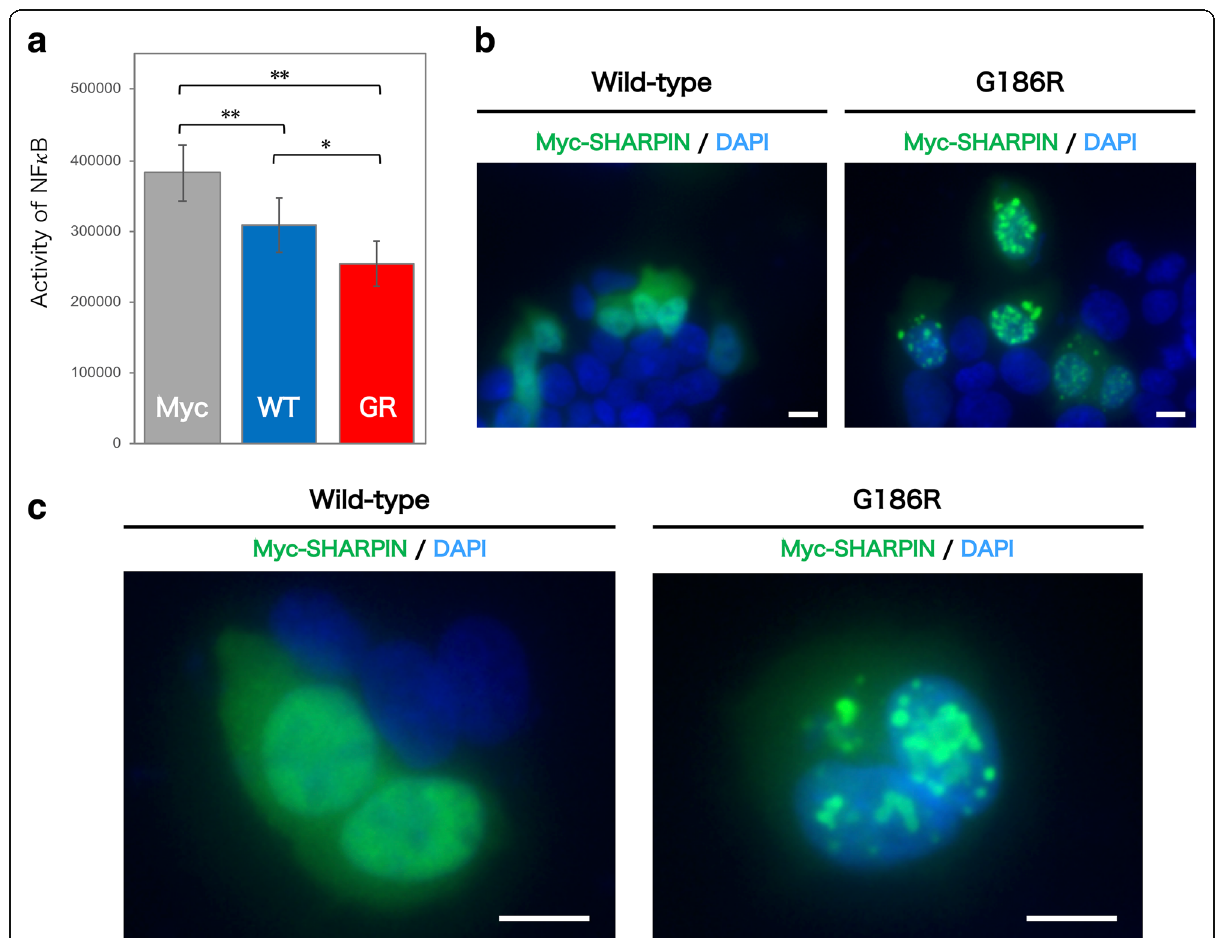
Fig. 2 Effect of the G186R variant on SHARPIN function. a NF- κ B activity in HEK293 cells under TNF- α – induced activation was determined by luciferase assay, which was performed three times with five replicates in each assay. Myc: Myc vector; WT: wild-type Myc-SHARPIN; GR: G186R variant of Myc-SHARPIN. *: p < 0.005; **: p < 0.0005. b Localization of Myc-SHARPIN visualized by immunocytochemistry in HEK293 cells. c Magnified images of Myc-SHARPIN. The G186R variant showed granular accumulations of Myc-SHARPIN. Scale bar: 10 μ